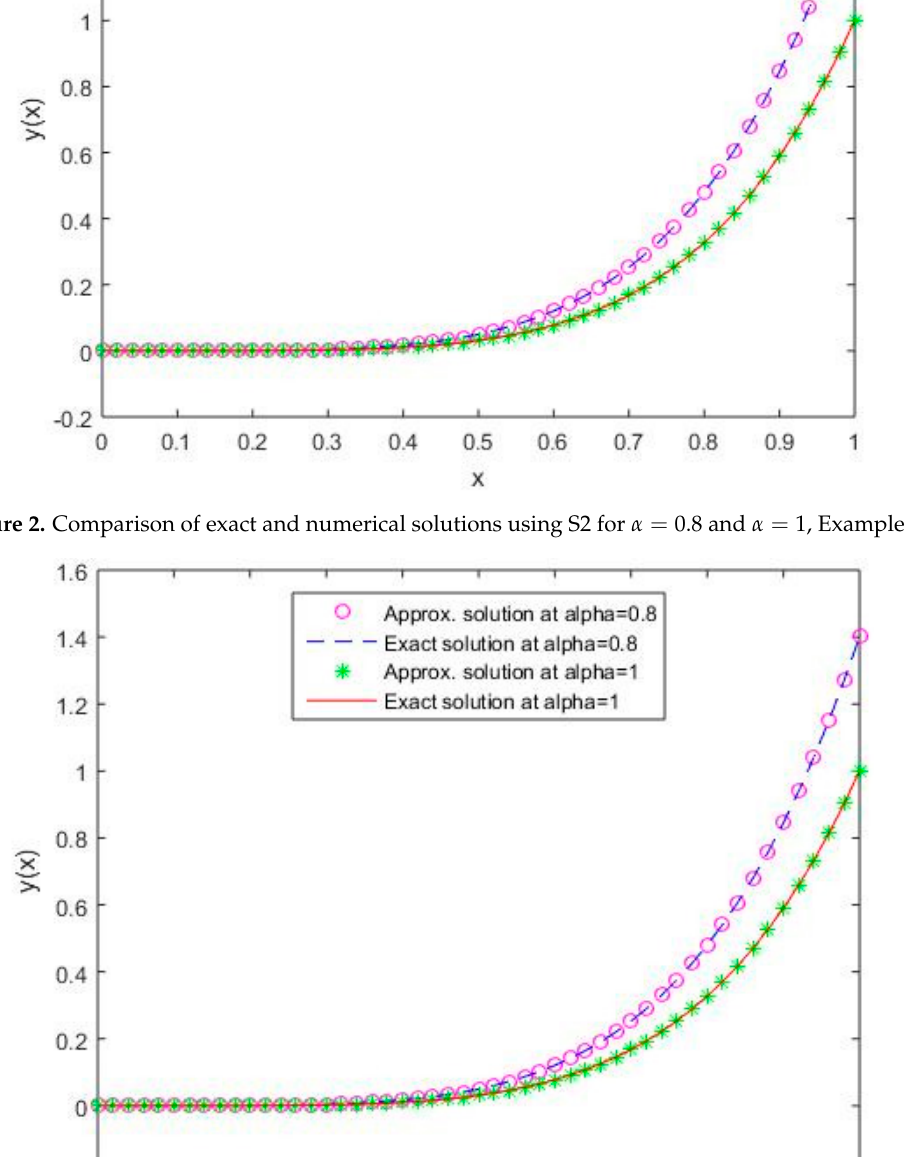
Figure 3. Comparison of exact and numerical solutions using S3 for α = 0.8 and α = 1, Example 1.